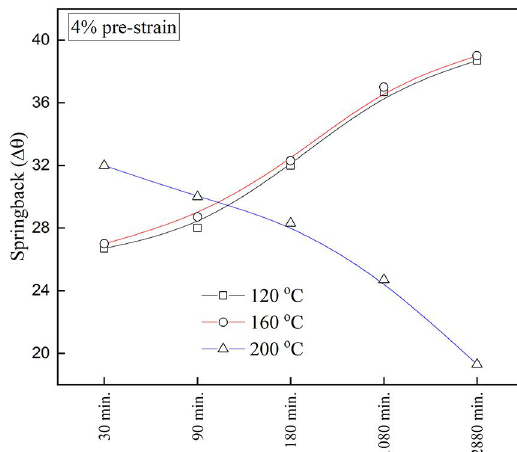
Figure 19. Effects of different aging temperatures and time on springback (4% pre-strain)